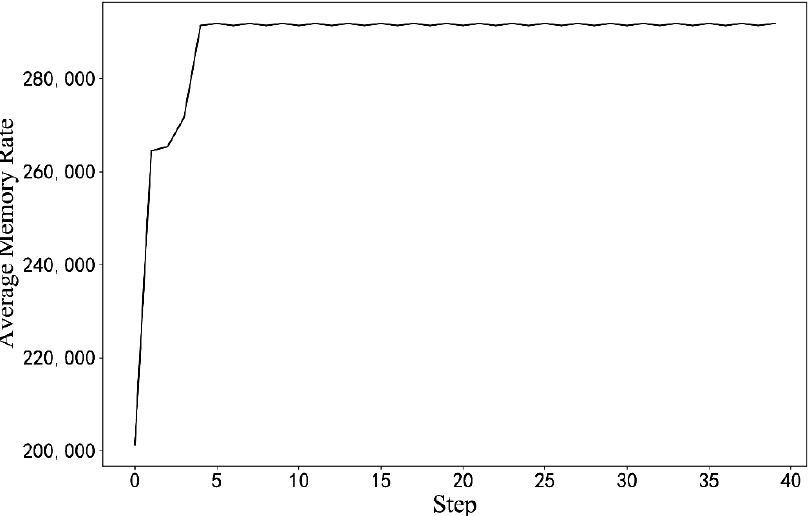
Figure 10. Optimization results from the initial configuration. (The results of the measured experi- ments).